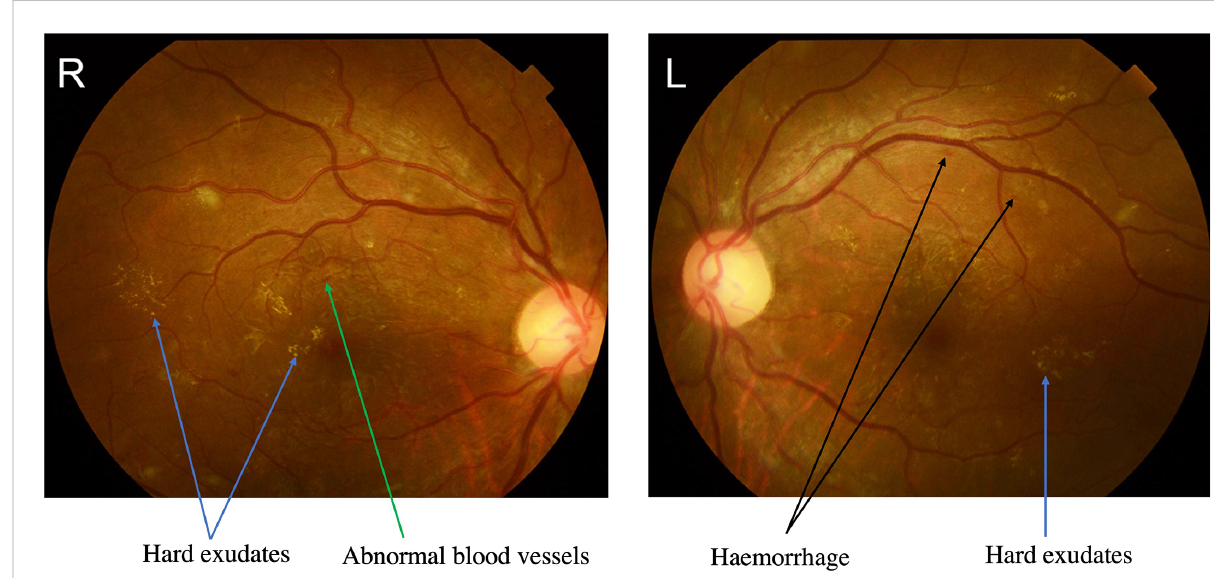
FIGURE 1 The fundus photographs showed severe proliferative diabetic retinopathy (DR). Proliferative DR showing abnormal blood vessels with green arrow, hard exudates with blue arrows and haemorrhage with black